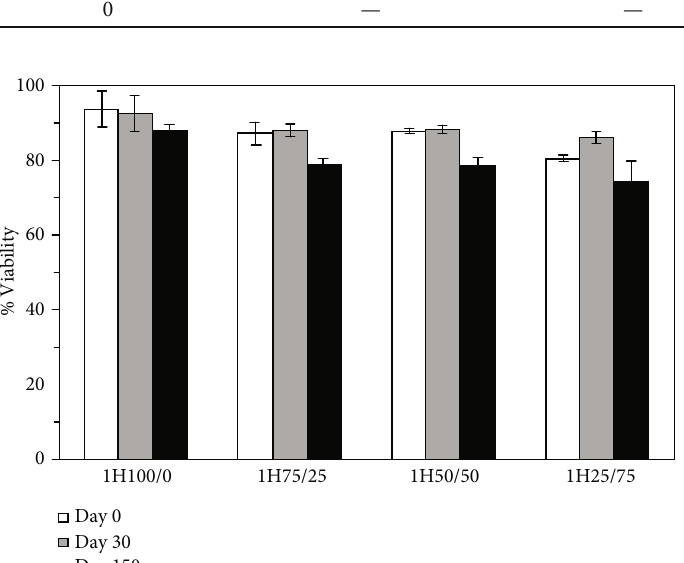
Figure 5: Indirect cytotoxicity of sca ff olds with di ff erent blending ratios with surface modi fi cation with 1M NaOH as evaluated by the viability of mouse fi broblast (L929)